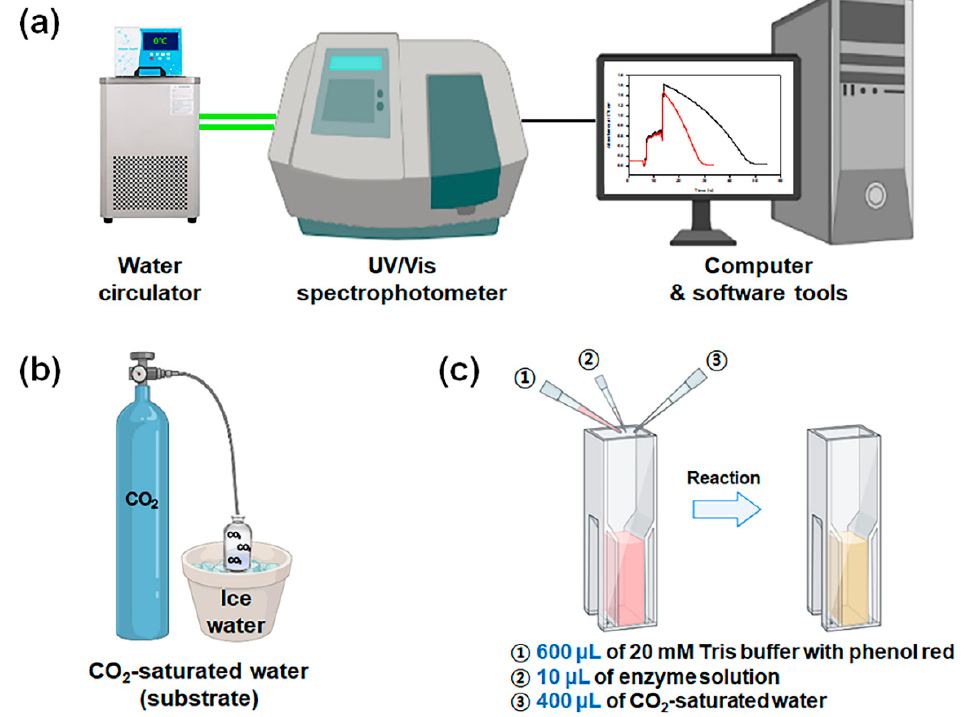
Figure 1. The facile, precise, and accurate assay for the colorimetric determination of CO 2 hydration activity. ( a ) Instrumental setup for spectrophotometer equipped with temperature-controllable cell holder. ( b ) Preparation of CO 2 -saturated water as the enzyme substrate. ( c ) Components of the CO 2 hydration reaction. Figures were created with BioRender.com.